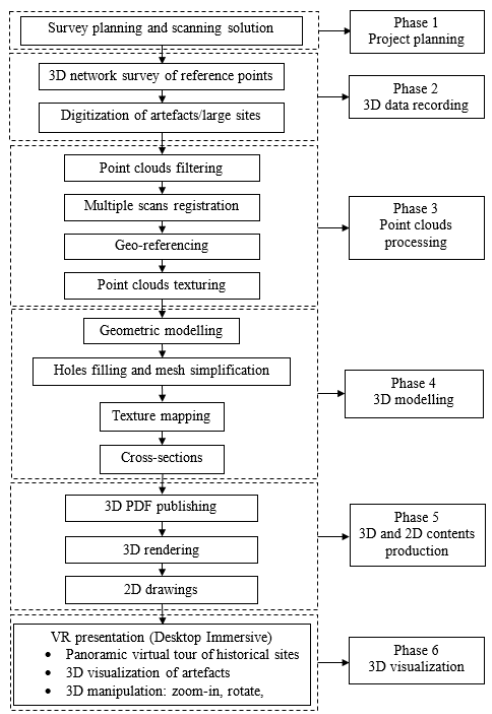
Figure 1. Overall research